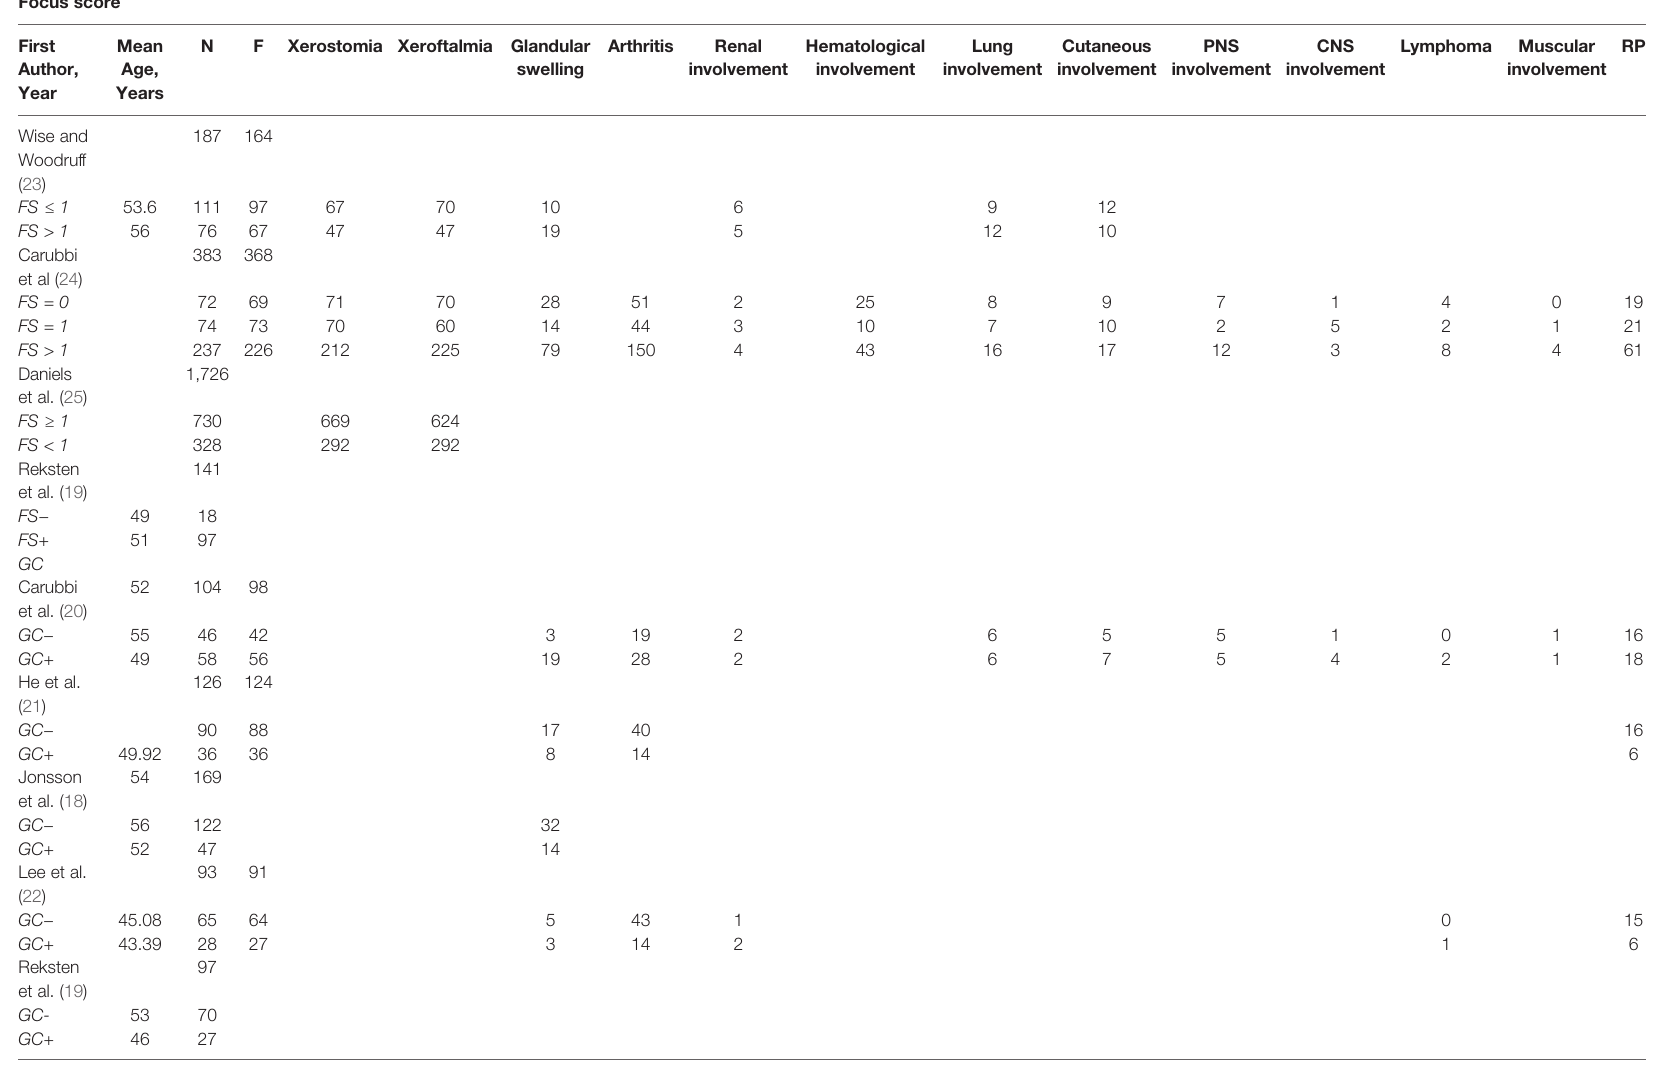
TABLE 3 | Main demographic and clinical characteristics of patients in selected